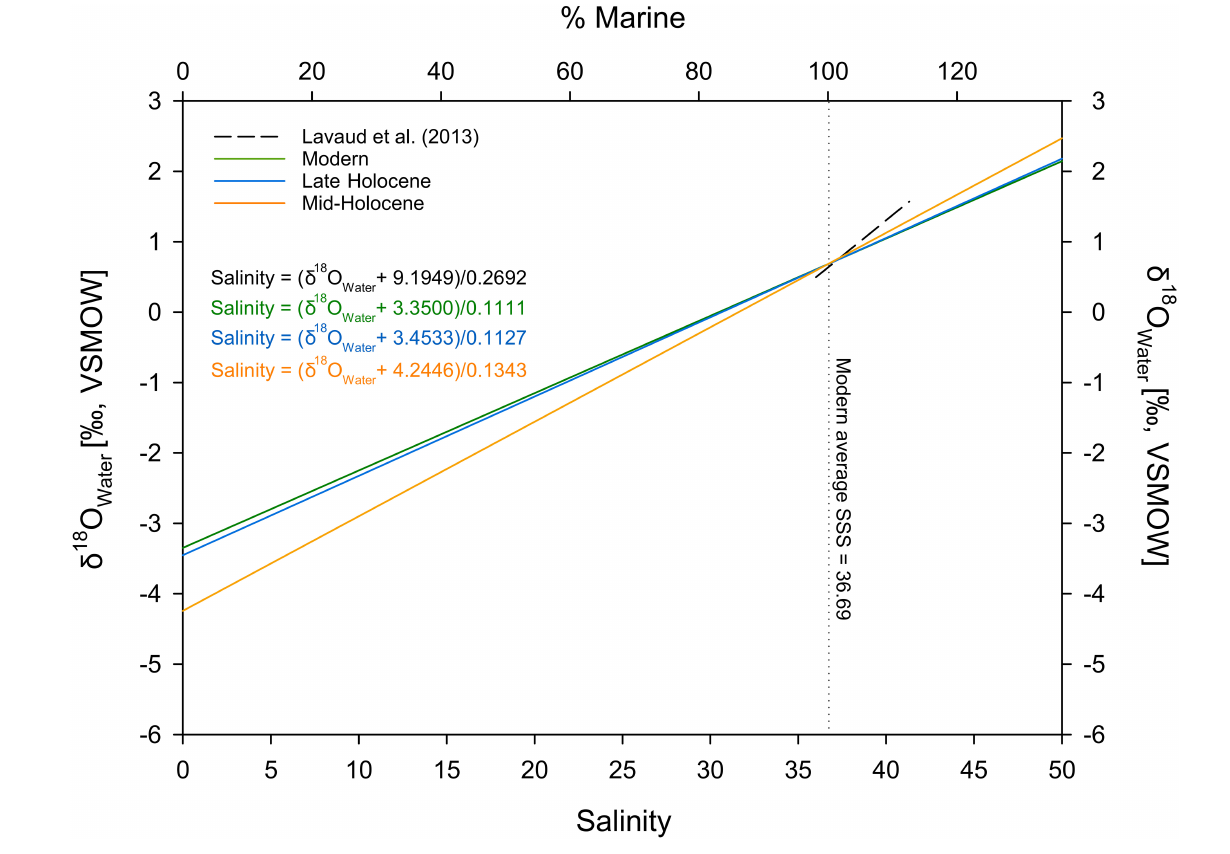
FIGURE 6 | δ 18 O Seawater –salinity models used for the estimation of mid- to late Holocene sea surface salinities (SSS). The modern average SSS was used as the marine end-member and corresponding δ 18 O Seawater values were calculated using the modern δ 18 O Seawater –salinity relationship of Lavaud et al. (2013). The intercept with the axis of ordinate shows the δ 18 O values of the freshwater end-members derived using the OIPC (Bowen and Revenaugh, 2003; Bowen, 2015; IAEA/WMO, 2015) (Ver. 2.2., available at wateriso.utah.edu/waterisotopes) and δ D-based approximations using the data of Tierney et al. (2017) for the modern and Holocene time intervals,